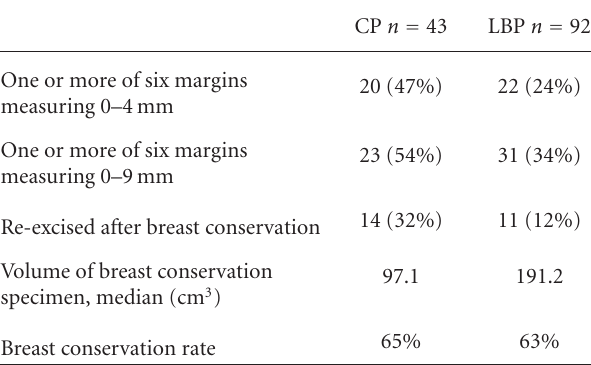
Table 5: Comparison of 135 consecutive breast conserving surgical specimens with DCIS. Conventional pathology without MRI (CP) and large format breast pathology with MRI